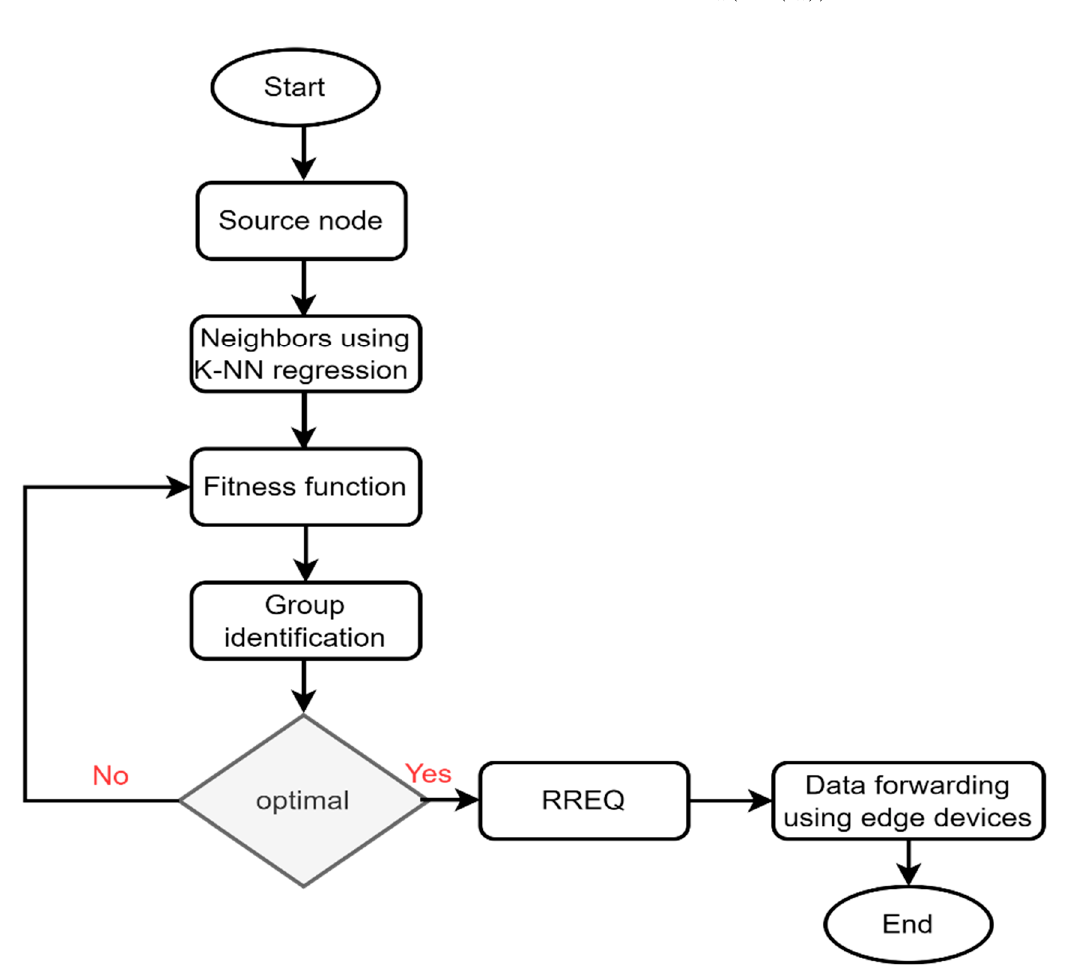
Figure 2. Flowchart of the proposed protocol for routing using group identification.